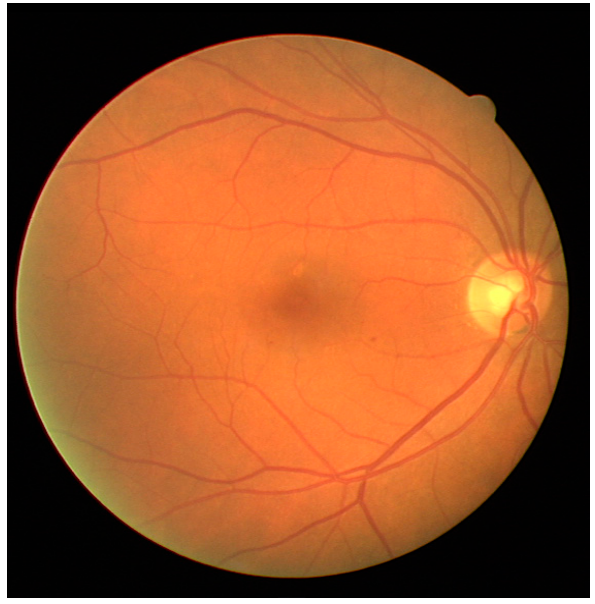
Figure 2. Example of a retinal image in digital retinal images for vessel extraction (DRIVE).